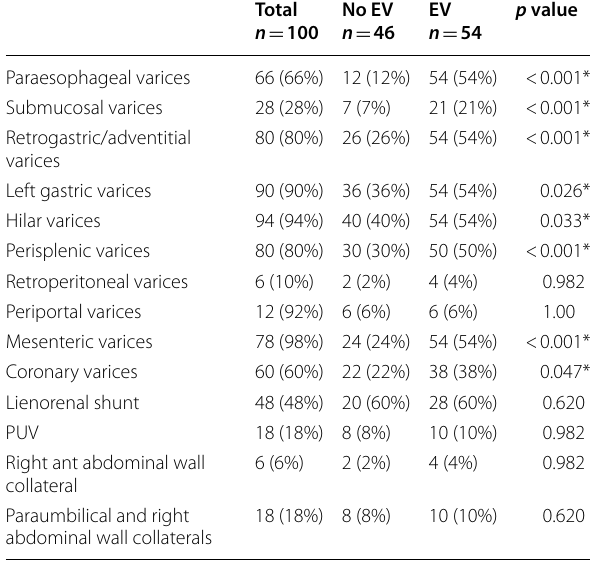
Table 4 Results of MDCT versus endoscopic assessment of EV of the study patients ( N 100) =